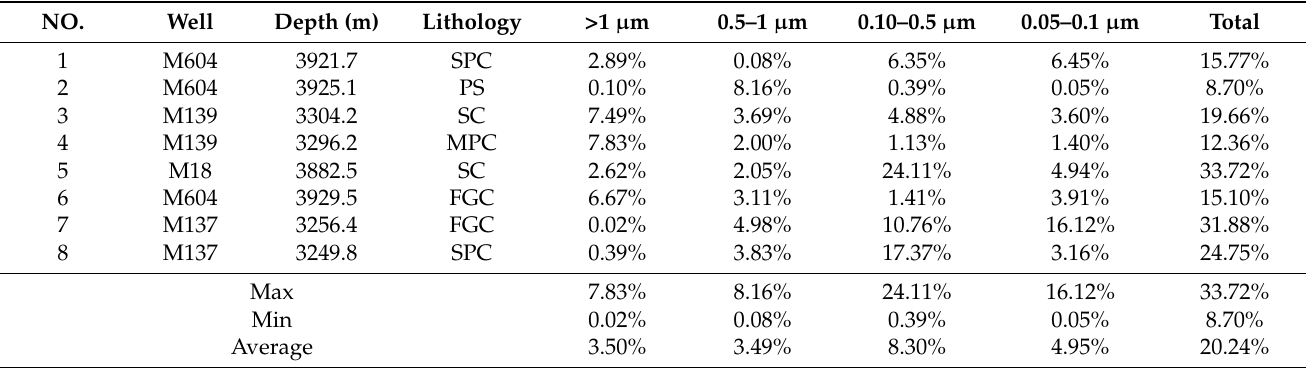
Table 4. Movable fluid saturation controlled by different throat radius